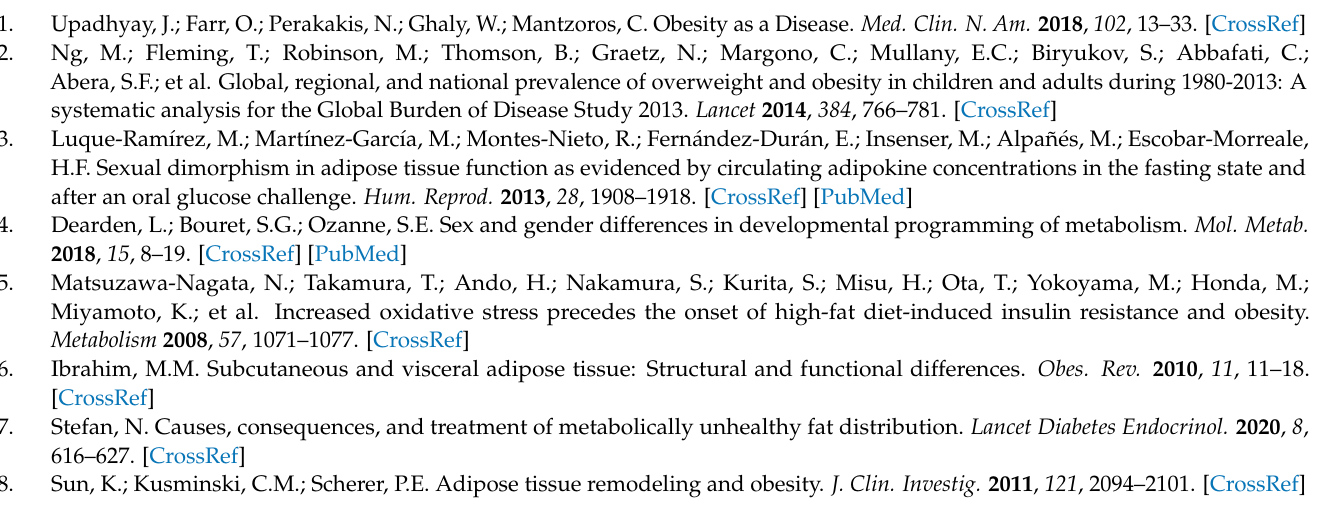
Figure S2: Representative image of the genomic mapping of hsa-miR-4643 in humans and schematic representation of predicted seed complementarity between the seed sequence of hsa-miR-4643, and seed region on ATP8A1 and ATP8B1 3 (cid:48) UTR. Table S1: GO biological process of miR-548b-5p gene targets. Table S2: GO biological process of miR-4643 gene